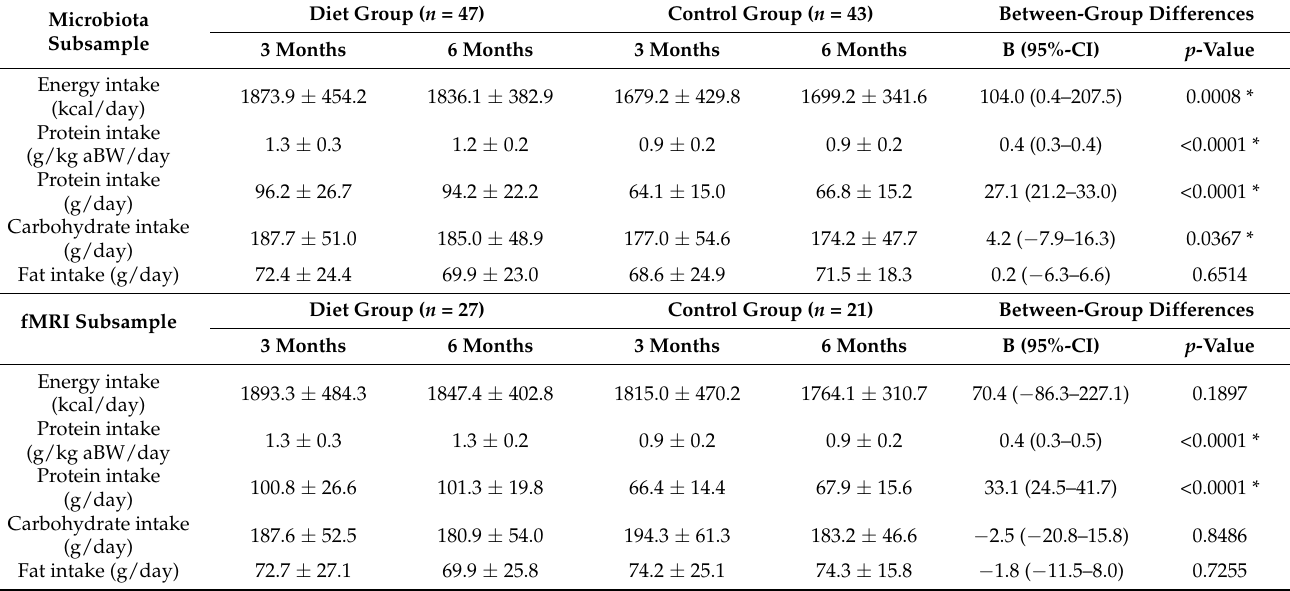
Table 2. Dietary intake after 3 and 6 months in the intervention and control groups.